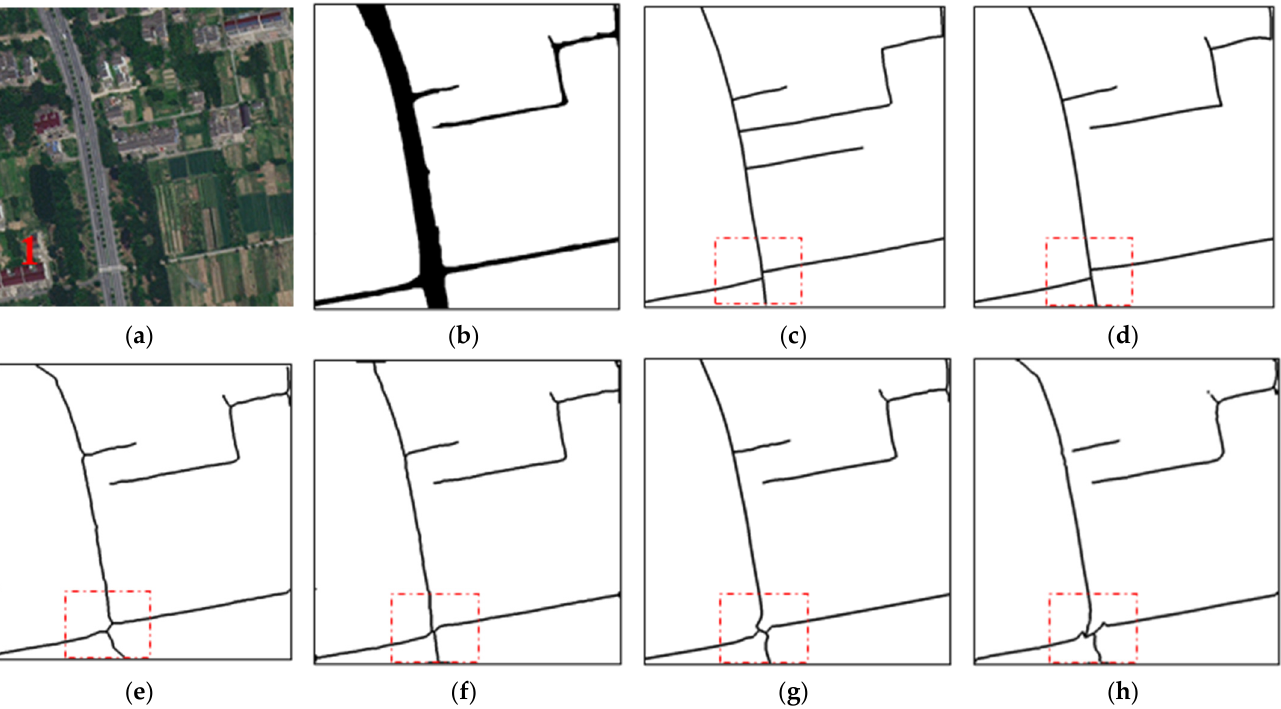
Figure 9. Experimental results for test image 1. ( a ) Original optical image. ( b ) Segmented road map. ( c ) Reference of the centerline map. ( d ) Result of the proposed method. ( e ) Result of the MT method. ( f ) Result of the ZST method. ( g ) Result of the MARS method. ( h ) Result of the NMS method.